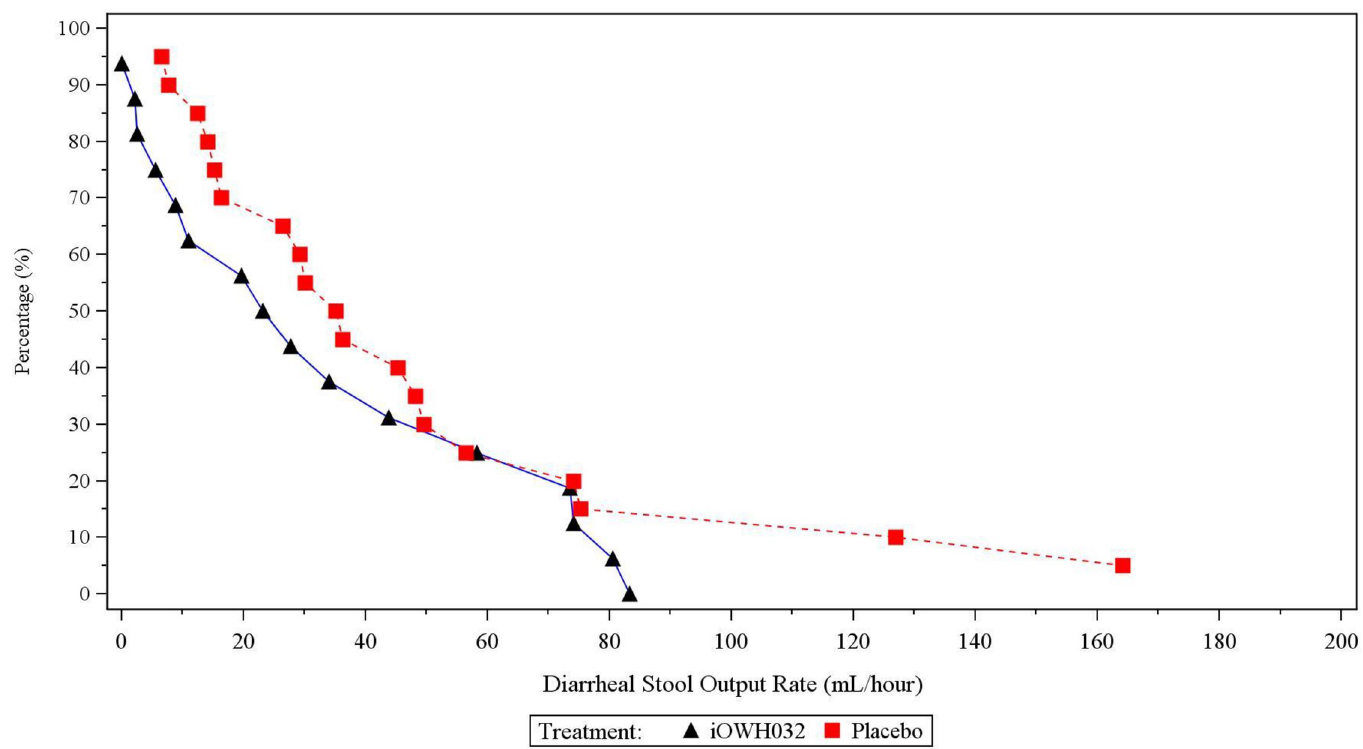
Fig 2. Reverse cumulative distribution plot for diarrheal stool output rate overall in the modified intent-to-treat population. The curve for the iOWH032 is shifted to the left of the placebo group, indicating a lower diarrheal stool output rate; however, this difference was not statistically significant (Van Elteren test: p =